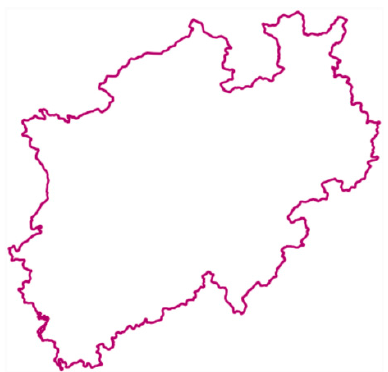
Figure 1. Simple vector data of the state of North-Rhine Westphalia (NRW) in Germany [17].